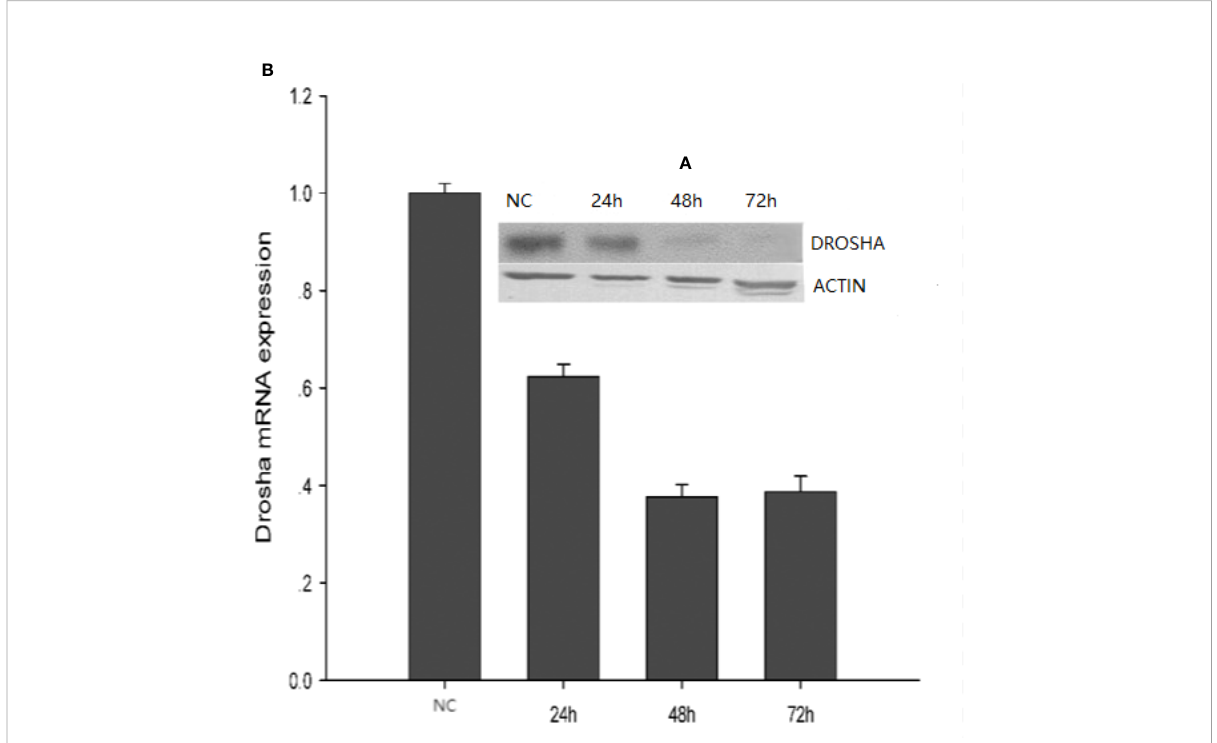
FIGURE 7 Expression of Drosha protein (A) and mRNA (B) at different transfection times. NC: Drosha -siRNA-FAM-NC. The siRNA sequence is not present in the fi sh.